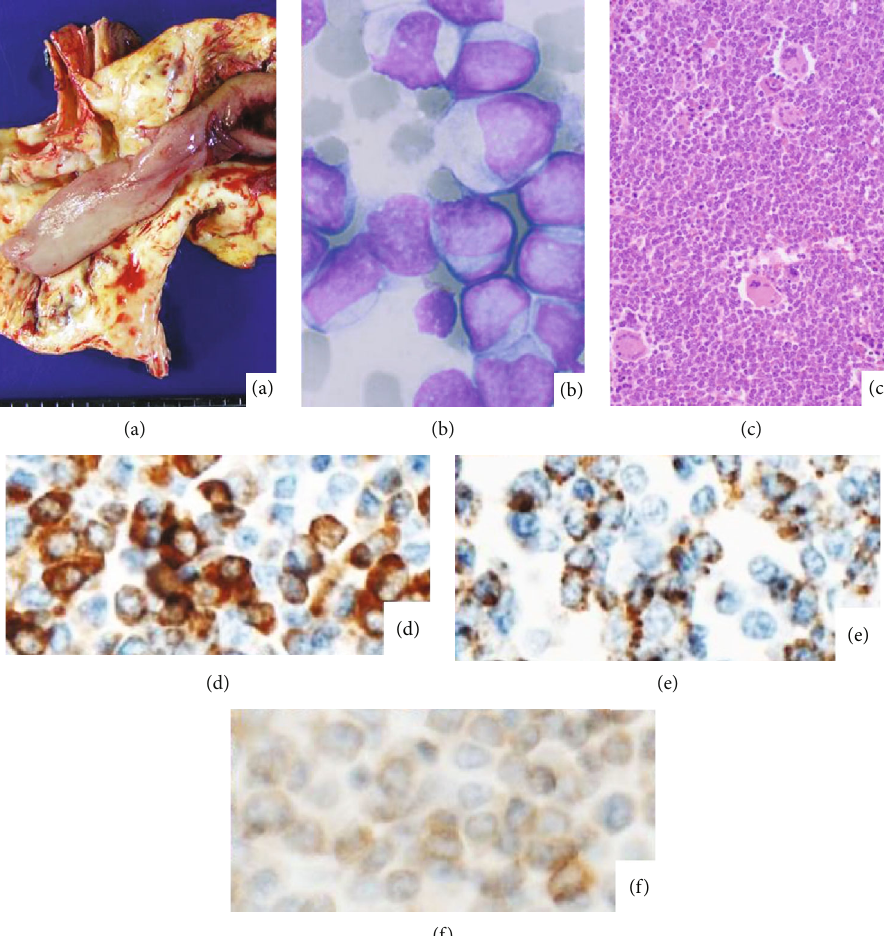
Figure 1: Features of leukemia cells ((a) gross appearance of lard-like blood clot in the aorta; (b) Giemsa-stained cytology of leukemia cells; (c) hematoxylin and eosin- (H&E-) stained histology of the bone marrow; immunostaining for MPO (d), CD34 (e), and CD117 (f)). The coagulated leukemia cells form white-colored elastic clots in the vascular space. The leukemic blasts in pleural e ff usion show high nuclear/cytoplasmic ratio and lack azurophilic granules. The bone marrow reveals 100% cellularity occasionally with megakaryocytic di ff erentiation. The blasts in the bone marrow are immunoreactive for MPO, CD34, and CD117